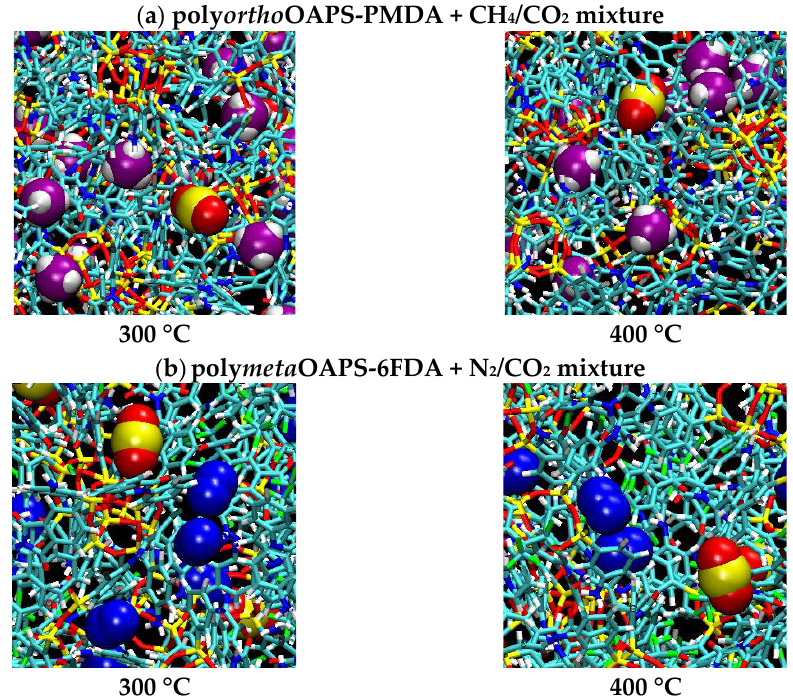
Figure 9. ~(20 Å ) 2 close-ups of ( a ) the sorbed CH 4 /CO 2 mixture in the poly ortho OAPS-PMDA matrix and ( b ) the sorbed N 2 /CO 2 mixture in the poly meta OAPS-6FDA matrix at high temperatures and for a mixed-gas pressure of 60 bar. Same color code as Figure 3 for the matrices. For the gases, methane: C = pink, H = white; carbon dioxide: C = yellow, O = red; nitrogen: N = blue.